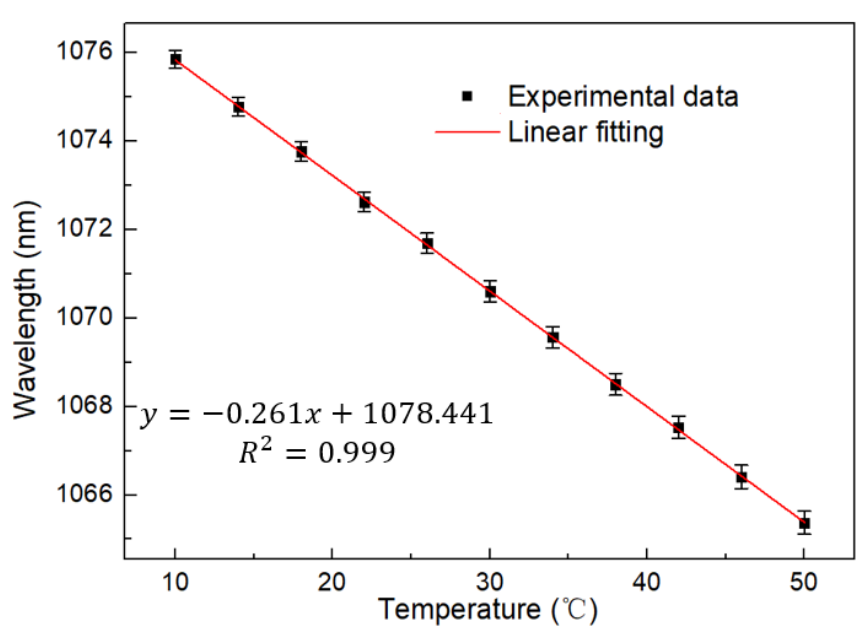
Figure 10. Linear regression curve of temperature with wavelength at FRL.